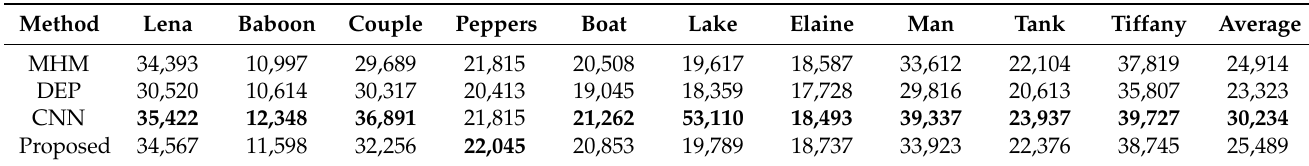
Table 2. Comparison of embedding capacity (bits) of the shadow layer of typical images. The best performance is marked in